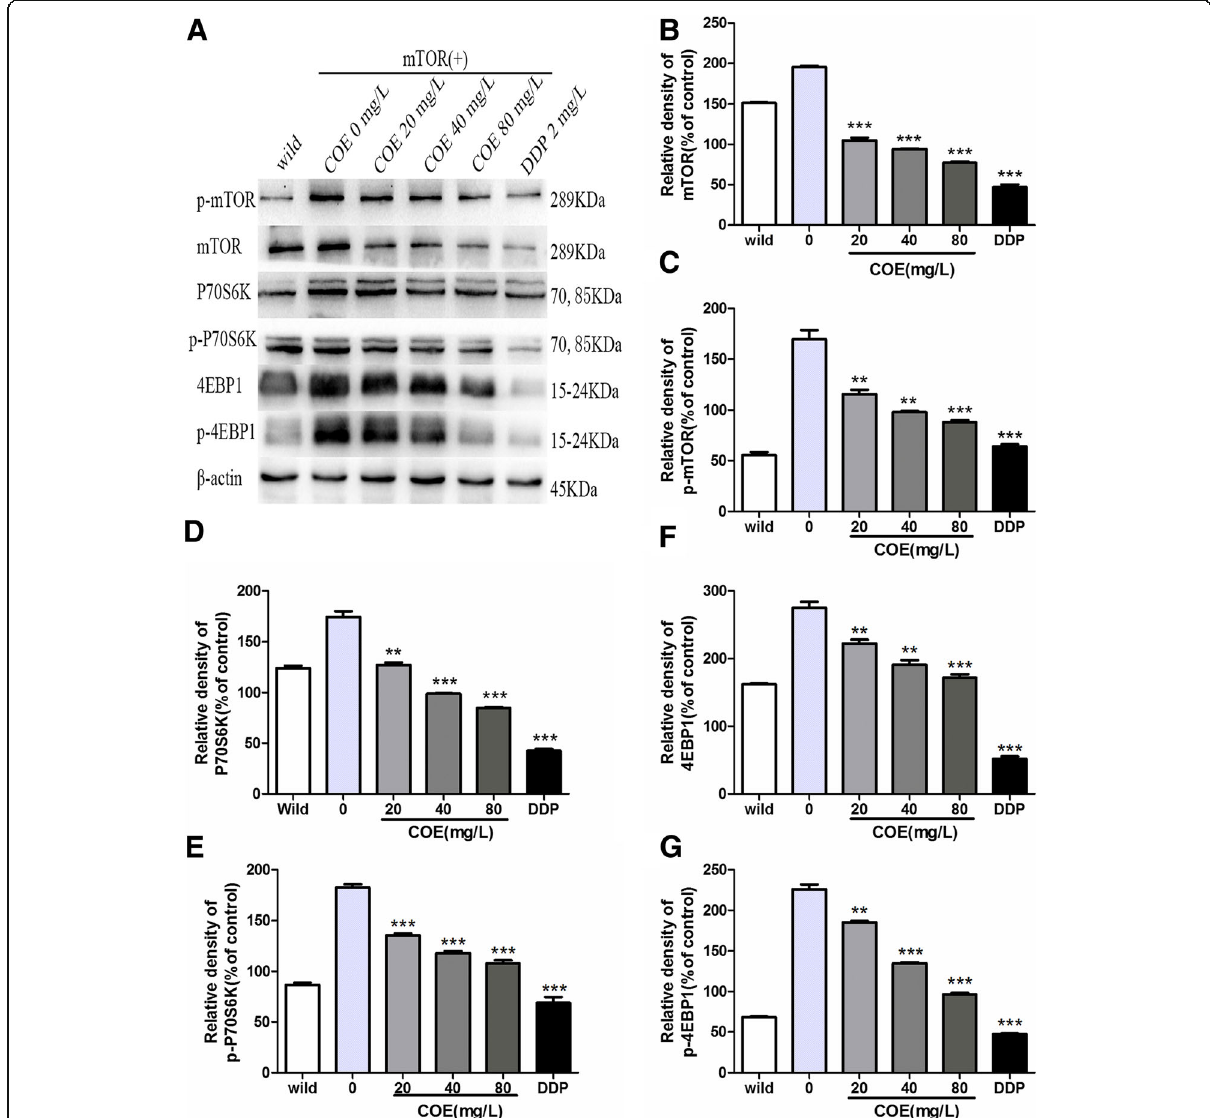
Fig. 5 Expression of the proteins that are involved in the mTOR signaling pathways. The HepG2/mTOR + cells were treated with 0.1%DMSO as solvent control, or 2 mg/L DDP, or different concentrations of COE (20, 40, and 80 mg/L) for 24 h. The proteins expression of mTOR, p-mTOR, 4E-BP1, p-4E-BP1, P70S6K, and p-P70S6K were studied by Western blot analysis. (** P < 0.01, *** P < 0.001, compared with the vehicle